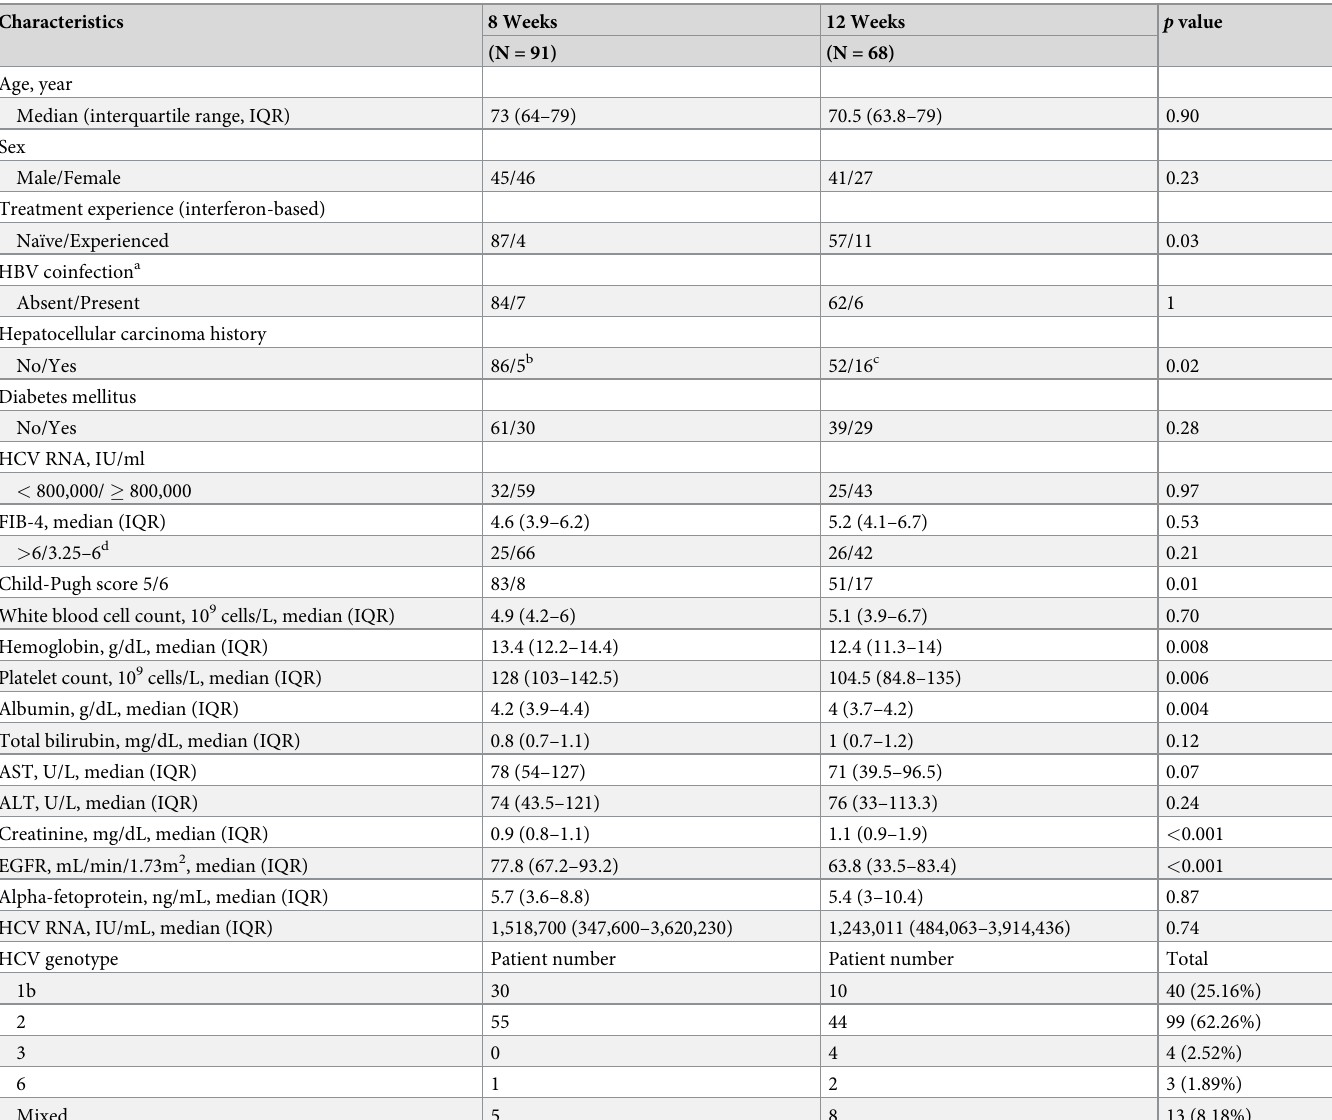
Table 1. Baseline patient